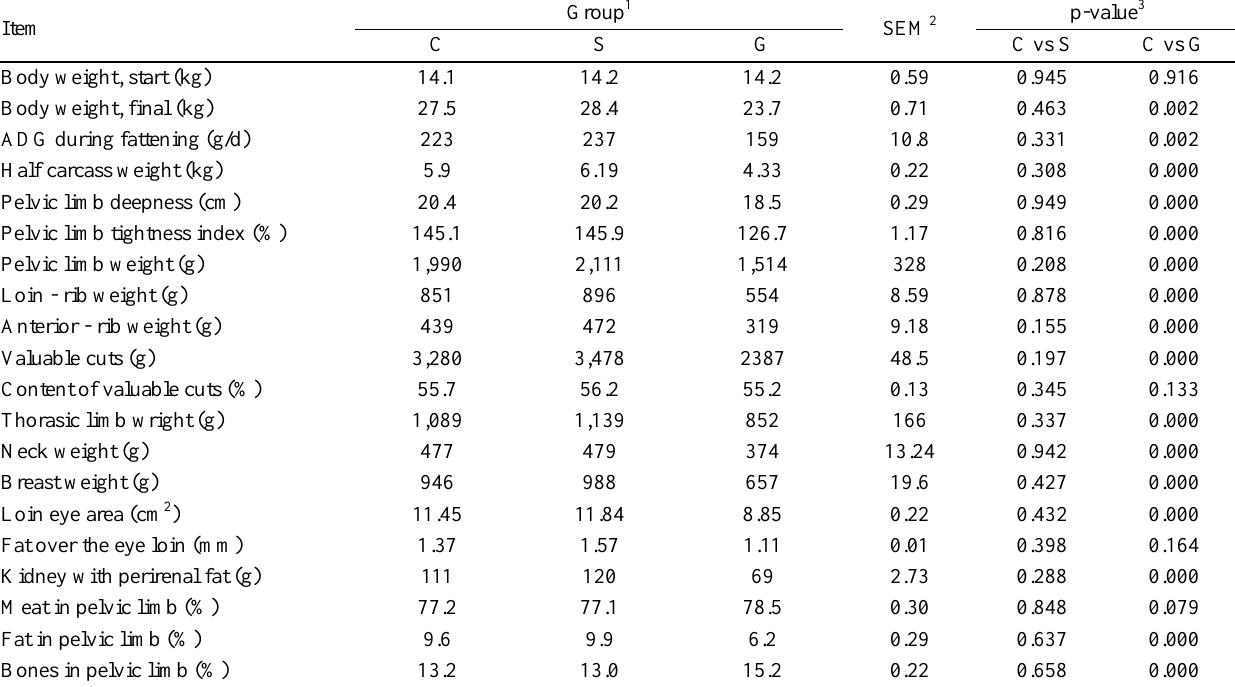
Table 2. Effect of housing systems and Se, Zn, and vitamin E supplementation on results of fattening and the carcass quality of